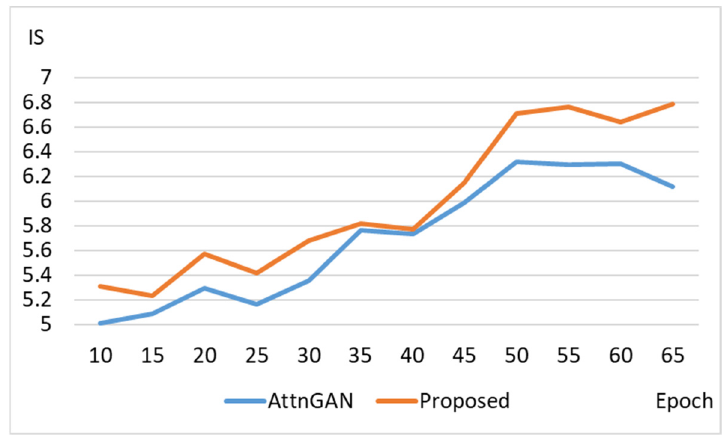
Figure 3. Comparisons on Inception Score.